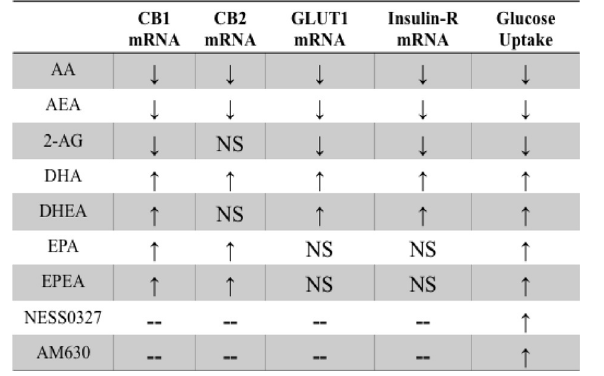
FIGURE 4 | The illustration summarizes the actions of PUFA, endocannabinoids, and cannabinoid antagonist and inverse agonist on glucose uptake and ECS gene expression in differentiated C2C12 myoblast cell cultures. Differentiated C2C12 cultures treated with AA and its derived ligands, AEA and 2-AG, led to lower basal glucose uptake compared to the BSA vehicle control group. Treatment with DHA, DHEA, EPA, and EPEA resulted in higher basal glucose uptake compared to the BSA control group. The higher levels of glucose uptake were comparable to the uptake observed with the CB1 antagonist, NESS0327. The figure is developed from the key observations found by treatment of C2C12 myoblast cell cultures with PUFA, endocannabinoids, and cannabinoid receptor antagonism on CB1, inverse agonist on CB2, and the measurement of GLUT1, insulin-R mRNA, and glucose uptake in differentiated C2C12. In the table below upward arrows represent higher expression/activity compared to the BSA vehicle control while downward arrows signify lower expression/activity compared to the BSA control. Differentiated C2C12 cultures treated with AA and its derived ligands, AEA and 2-AG, led to lower CB1, GLUT1, and insulin-R mRNA expression as well as a reduction of basal glucose uptake compared to the BSA control group. Treatment with DHA, DHEA, EPA, and EPEA resulted in higher CB1, and DHA or DHEA higher GLUT1 and insulin-R mRNA expression as well as a greater level of glucose uptake compared to the BSA control group. NS indicates not significant from the BSA control